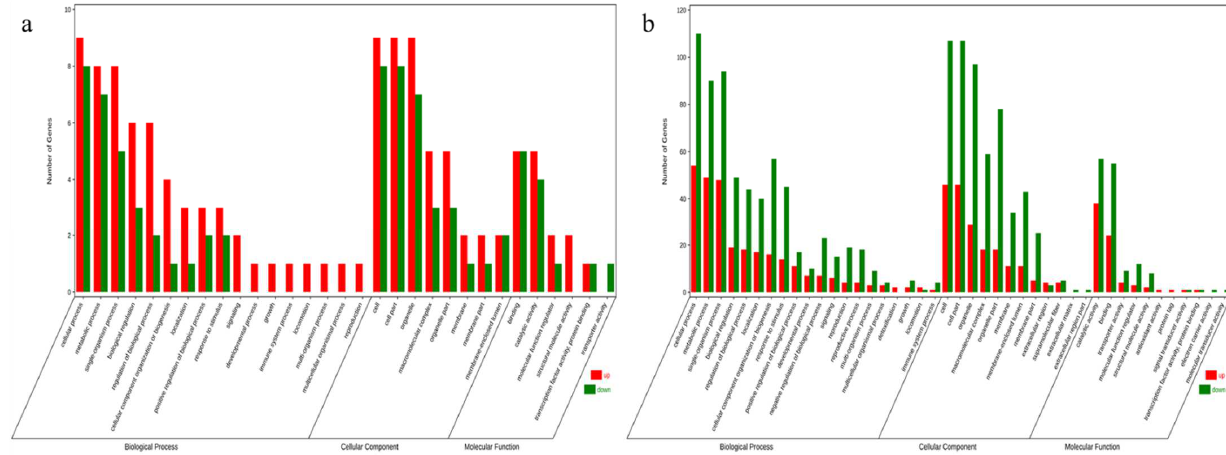
Figure 4. GO class of DEGs under different treatments ( a ) and different parts ( b ) of G. dilepis